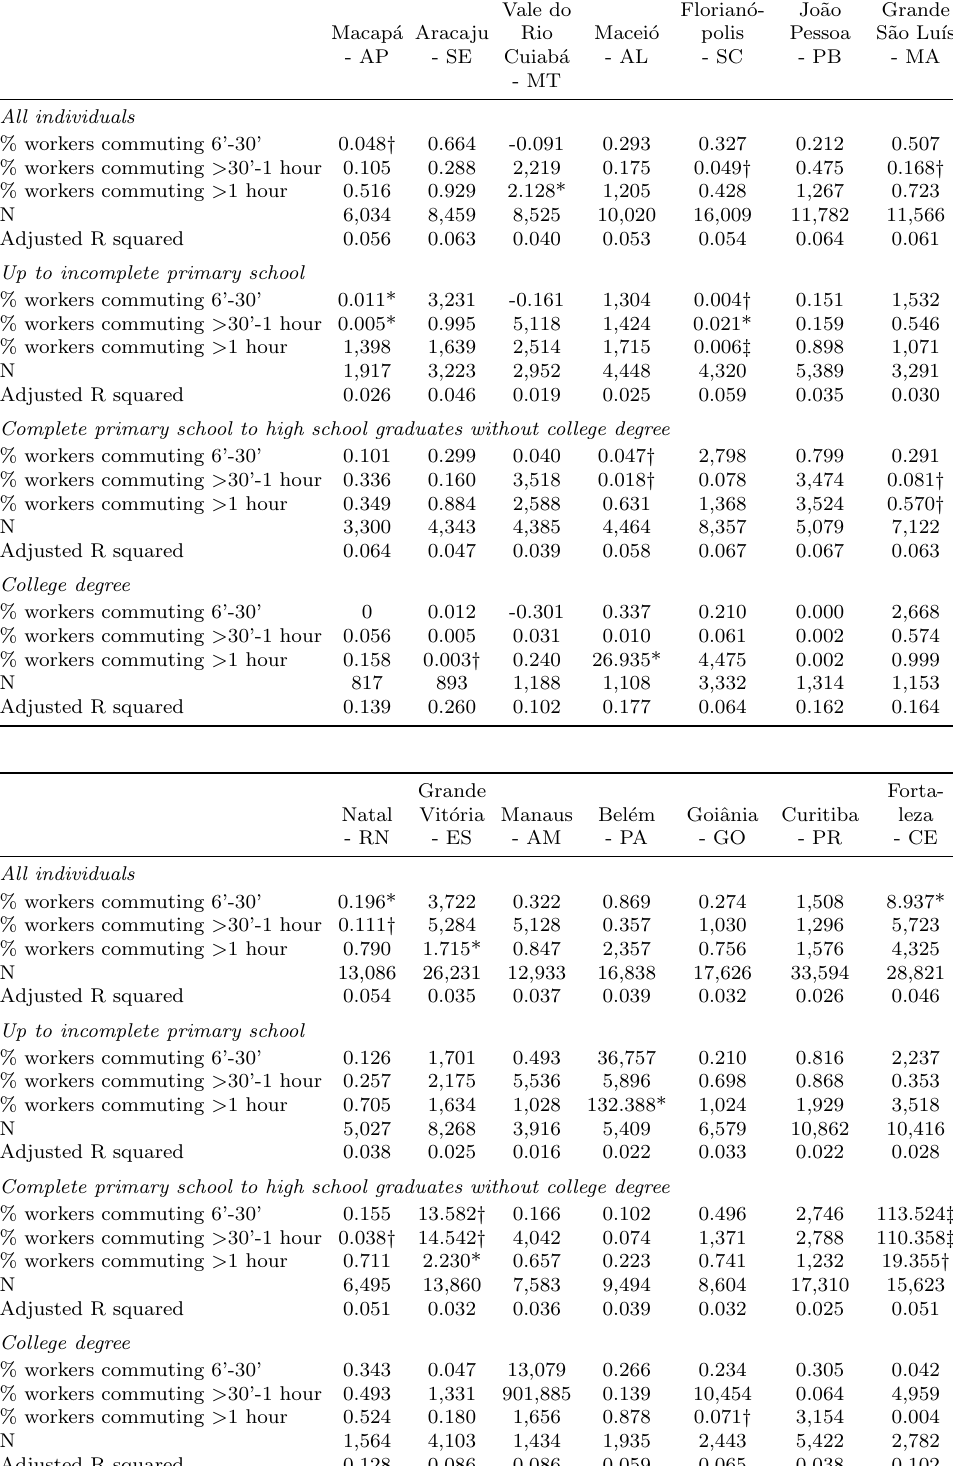
Table 7: Logit model for the probability of being unemployed, regressions with all individuals and by education